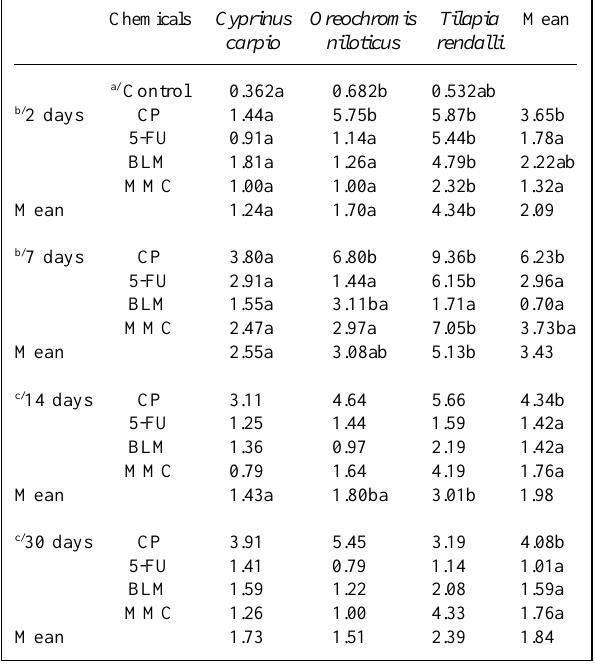
Table II - Means of micronuclei at 2, 7, 14 and 30 days after CP, 5-FU, BLM and MMC treatment.